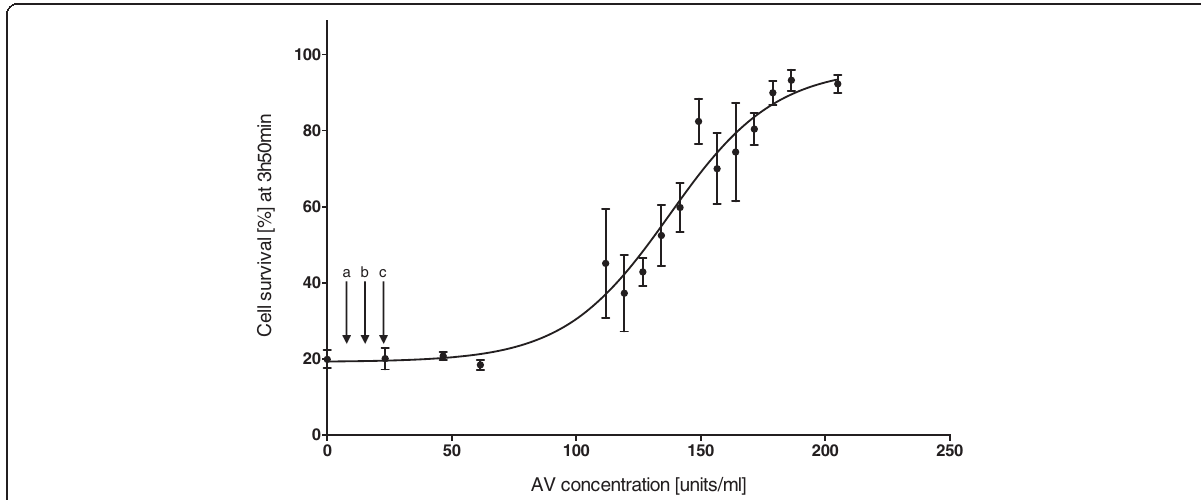
Figure 1 Dose – response curve of C. fleckeri antivenom against a 1.47 μ g/mL of venom for three hours and 50 minutes after exposure to the cells. The error bars represent 95% CI for each mean (three replicates). The currently recommended dose for human envenomation – of one, two and three vials – is indicated (a, b and c, respectively) for